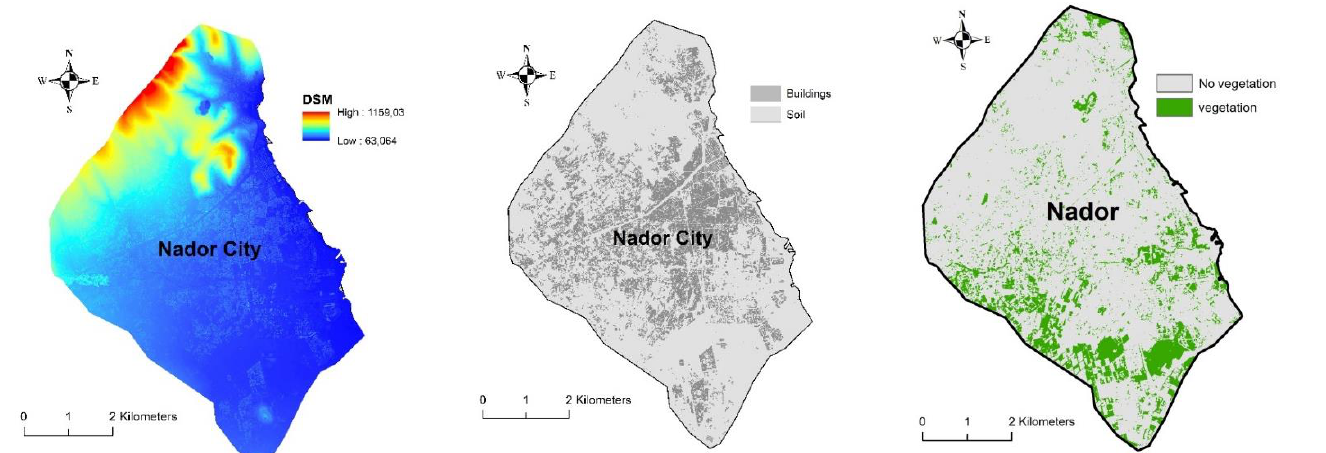
Figure 3. Digital Surface Model, footprint of buildings and green spaces of Nador